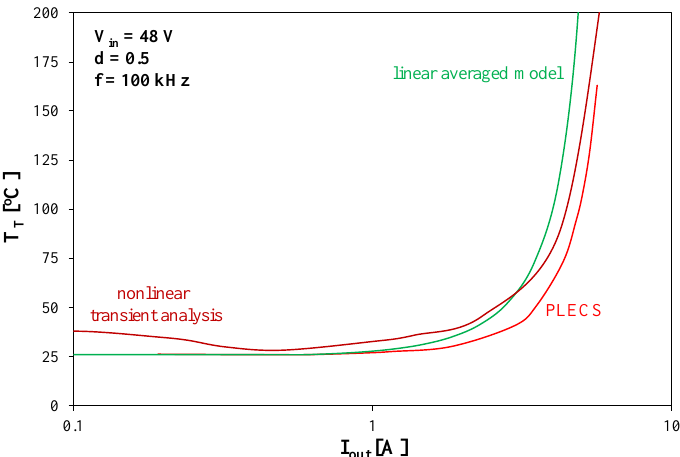
Figure 9. Computed dependences of the transistor internal temperature on the converter output current at V in = 48 V.